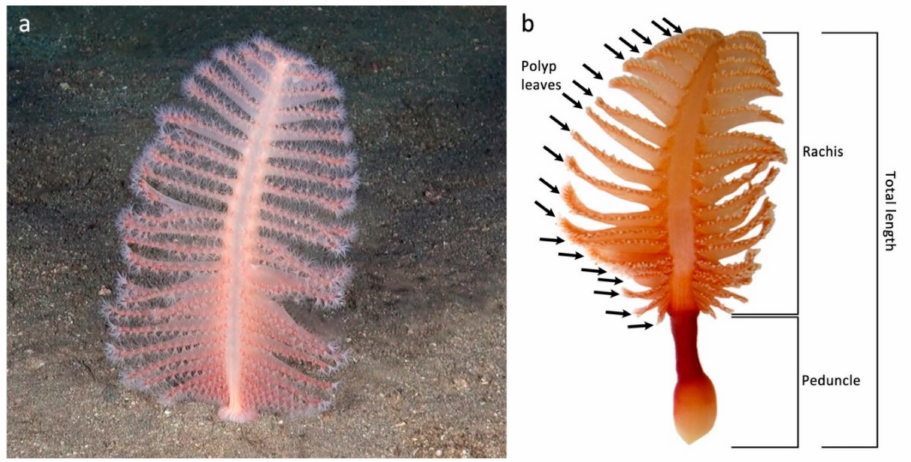
Figure 1. The colony of Pennatula rubra . ( a ) In vivo appearance of the species; ( b ) indication of polyp leaves (black arrows), rachis, peduncle, and total